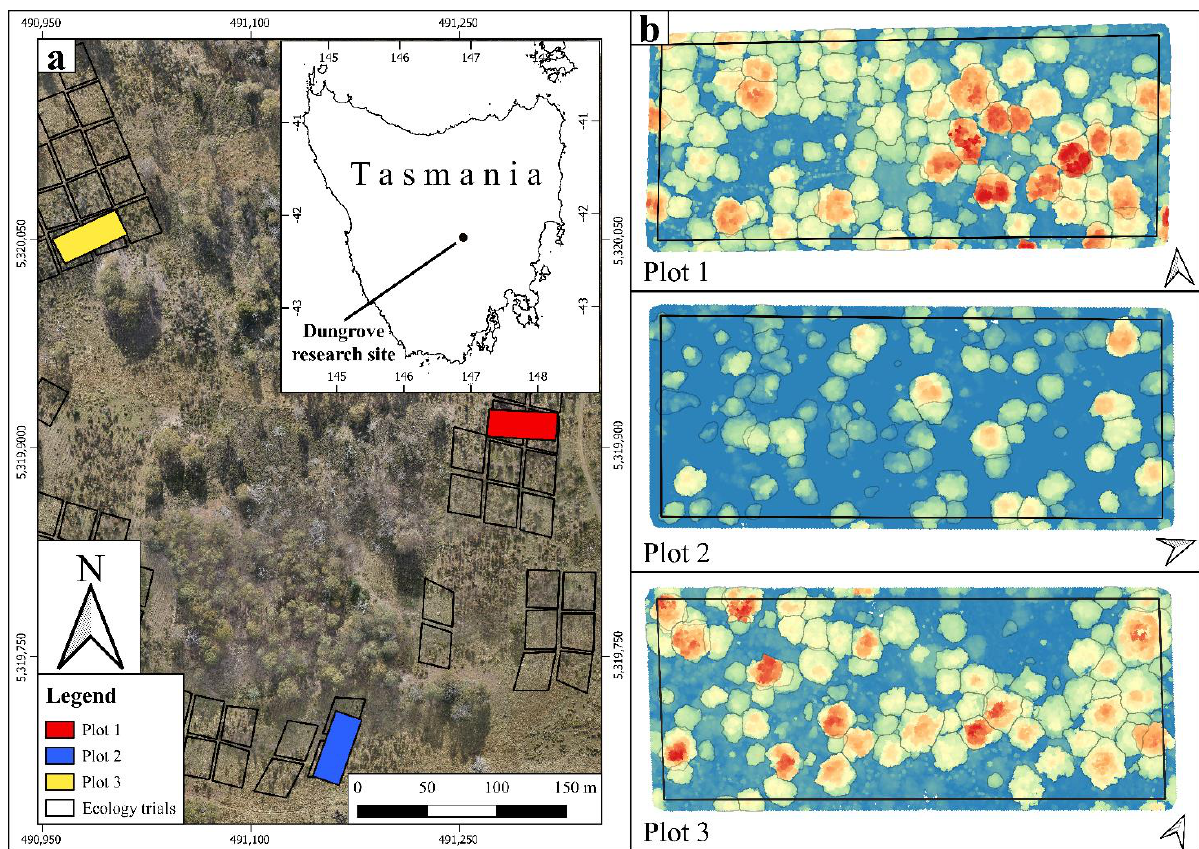
Figure 1. ( a ) The Dungrove research site showing the locations of the three permanent plots (red, blue, yellow polygons) superimposed over the broader experimental plantings of the Ecology trial (black polygons) and site position within Tasmania (inset map—coordinates in WGS 84, EPSG:4326); ( b ) the three Canopy Height Models (CHMs) of the ZEB1 plots, acquired in 2019, shown with individual crowns overlaid and their 50 × 20 m bounding box, colored according to aboveground height (blue to red = 0–10 m). The coordinate system used in map ( a ) is GDA94/MGA zone 55S, EPSG:28355.